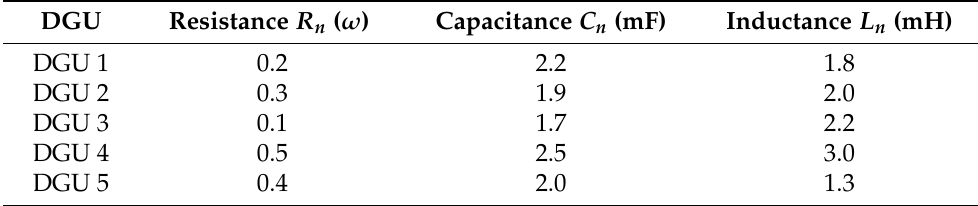
Table 1. Electrical parameters of the